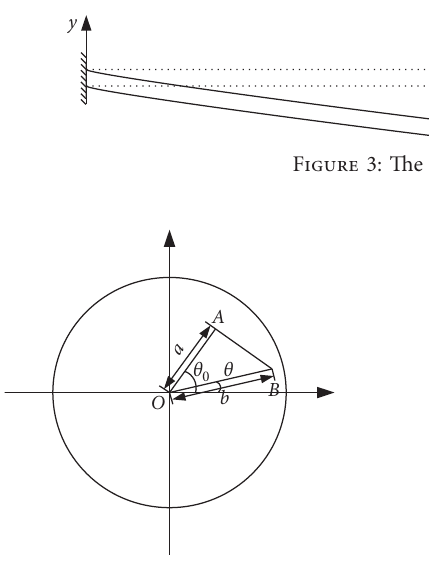
Figure 4: The plane projection of a circular thin